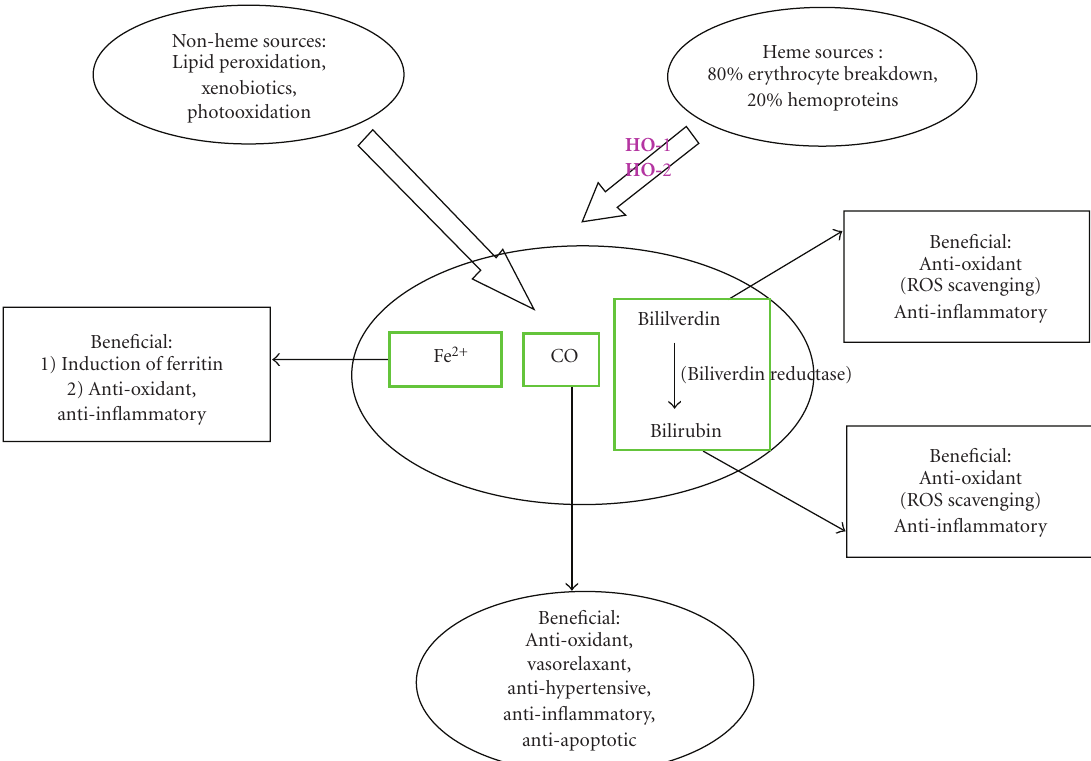
Figure 1: In the human body, carbon monoxide is formed at a rate of 16.4 μ mol/h and daily production can reach 500 μ M (Piantadosi, Antioxid Redox Signal, 2002, 4:259-70). About 86% comes from HO-catalyzed degradation of heme while 14% from lopid peroxidation xenobiotics and other